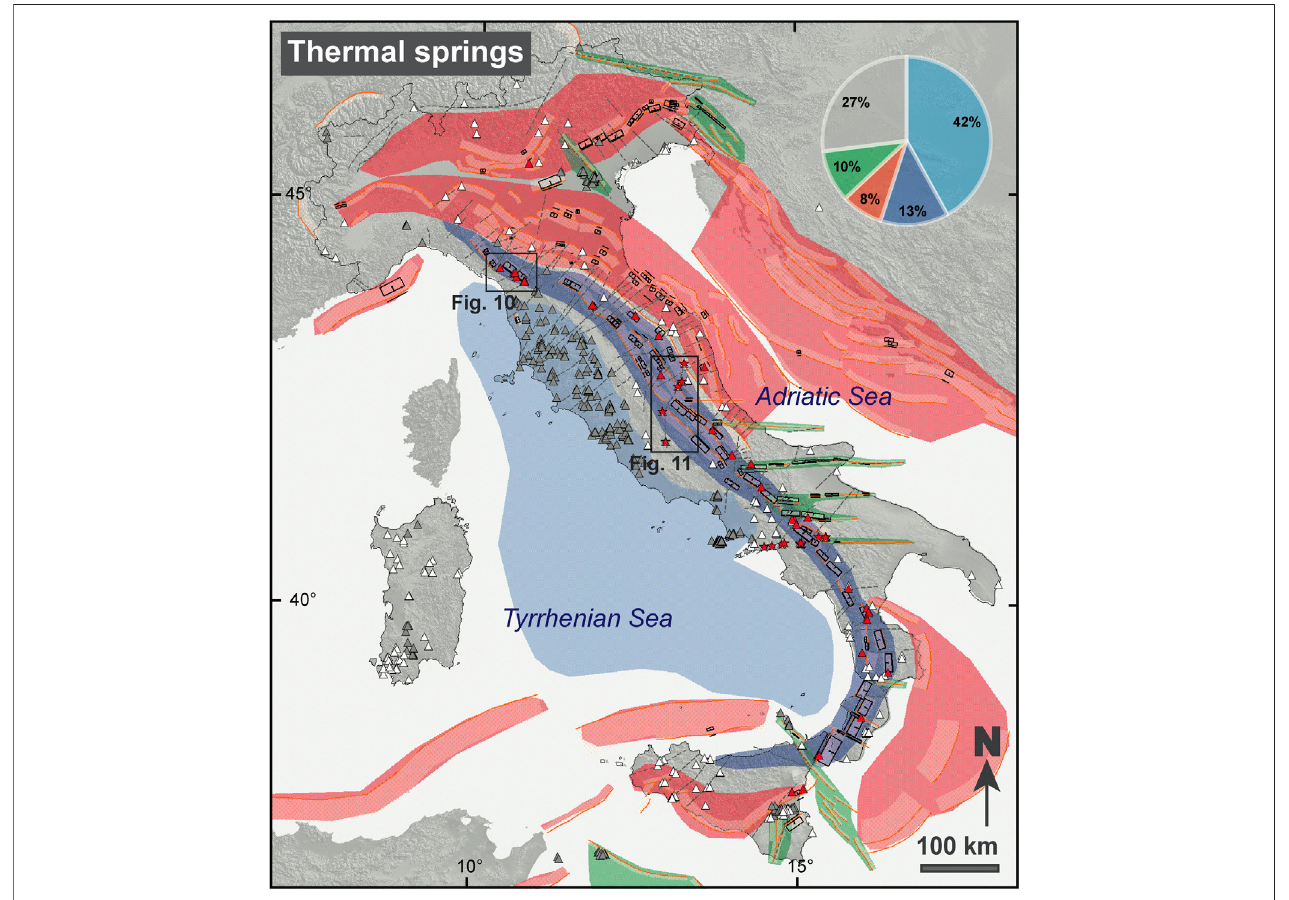
FIGURE 4 | Distribution of thermal springs (see Thermal Springs , Thermal Springs and Thermal Springs: Potential Evidence for Lithospheric Discontinuities ). Tectonic domains, seismogenic sources and transverse lineaments are shown as in Figure 2 . Removed datapoints are shown in grey. Selected datapoints are shown in red if they fall within 5 km of the edge of the surface projection of an Individual Seismogenic Source, otherwise in white. Red stars indicate additional critical datapoints discussed in the text. Two rectangles indicate the area discussed in Test Case 1: The Garfagnana Region, Northern Apennines and TestCase2:TheOlevano – Antrodoco – SibilliniLine,CentralApennines Sections. Thepiechartshowsthedistributionofthermalspringsinthedifferentactive tectonic domains (see Table 1 ). Notice that 42% of the springs fall in the area of rifting and mantle upwelling.